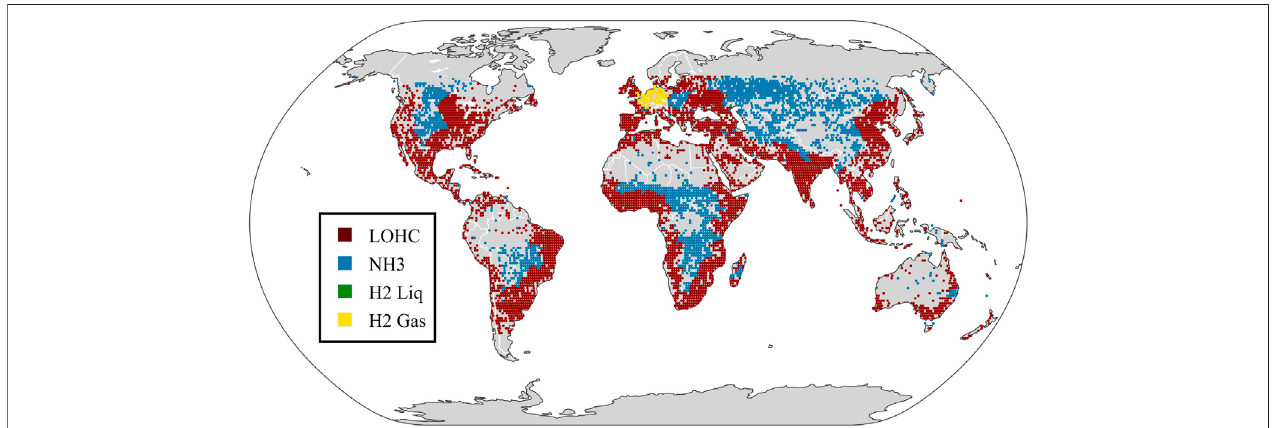
FIGURE 7 | The most cost-effective transport medium for H 2 required in Cologne, Germany, in the baseline scenario (100 kt/y AE electrolyser in 2030, centralised reconversion), from each of the 5970 selected global locations. Pipelines are not considered as a transport method in this scenario. Results are from a Monte Carlo simulation with 1,000 iterations.